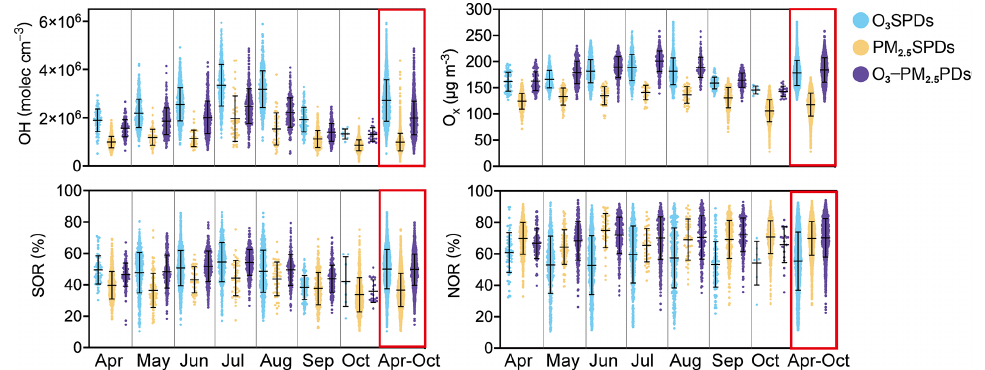
Figure 5. The boxplots of surface-layer hydroxyl radical (OH, molec.cm − 3 ), total oxidant (O x , µgm − 3 ), sulfur oxidation ratio (SOR, %), and nitrogen oxidation ratio (NOR, %) for model-captured O 3 SPDs, PM 2 . 5 SPDs, and O 3 –PM 2 . 5 PDs in 18 grids of BTH in the months of April to October from 2013 to 2020. The whiskers represent the standard deviation, and the black line represents the mean value of the